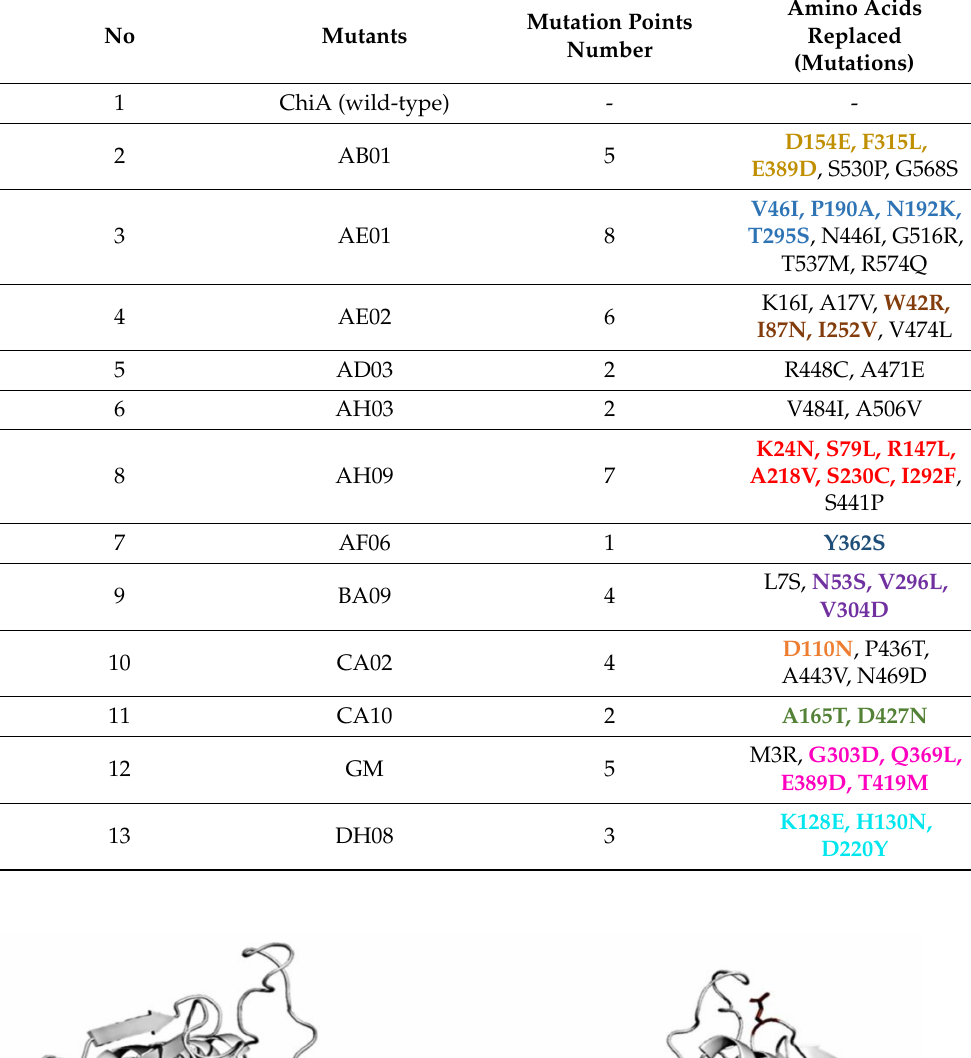
Table 1. Positions of mutations in the 12 ChiA mutants identified by FACS-based screening. The sequences were analyzed using Vector NTI software. The color codes correspond to those in Figure 6.